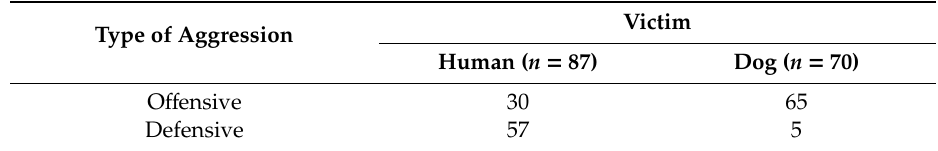
Table 19. Comparisons between the type of victim and type of aggression.